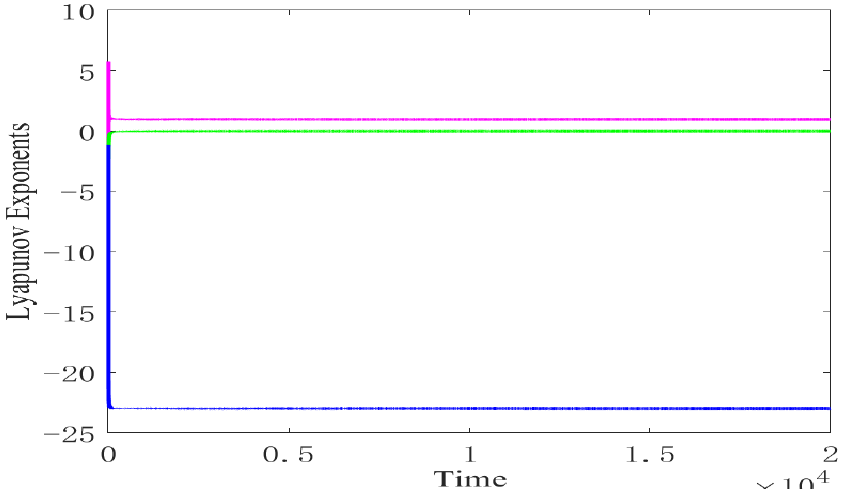
Figure 1. Lyapunov exponent spectrum of the new system (2) for ( a , b , c , k ) = ( 12,100,10,4.6 )